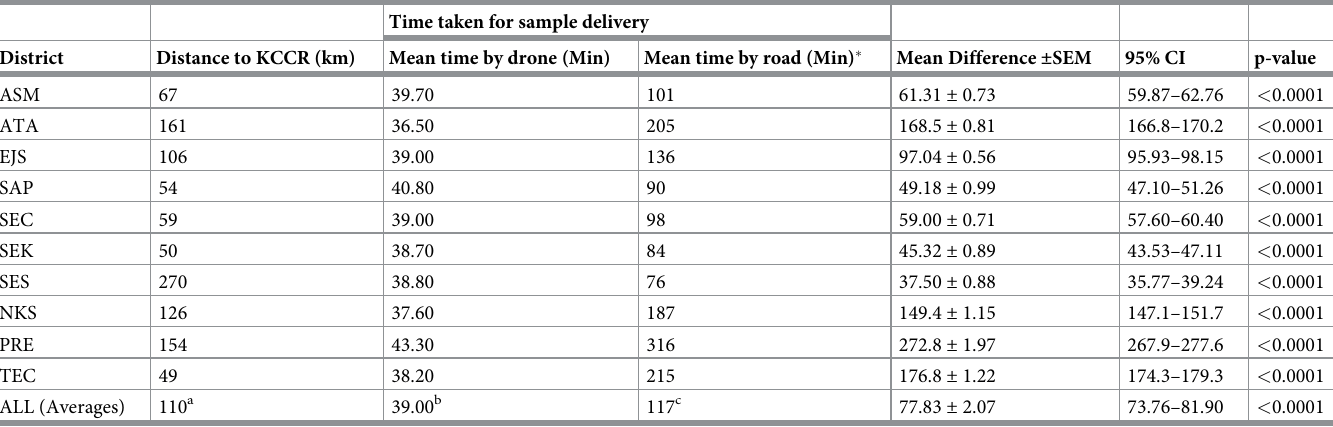
Table 4. Comparison of time taken for sample delivery by road and by